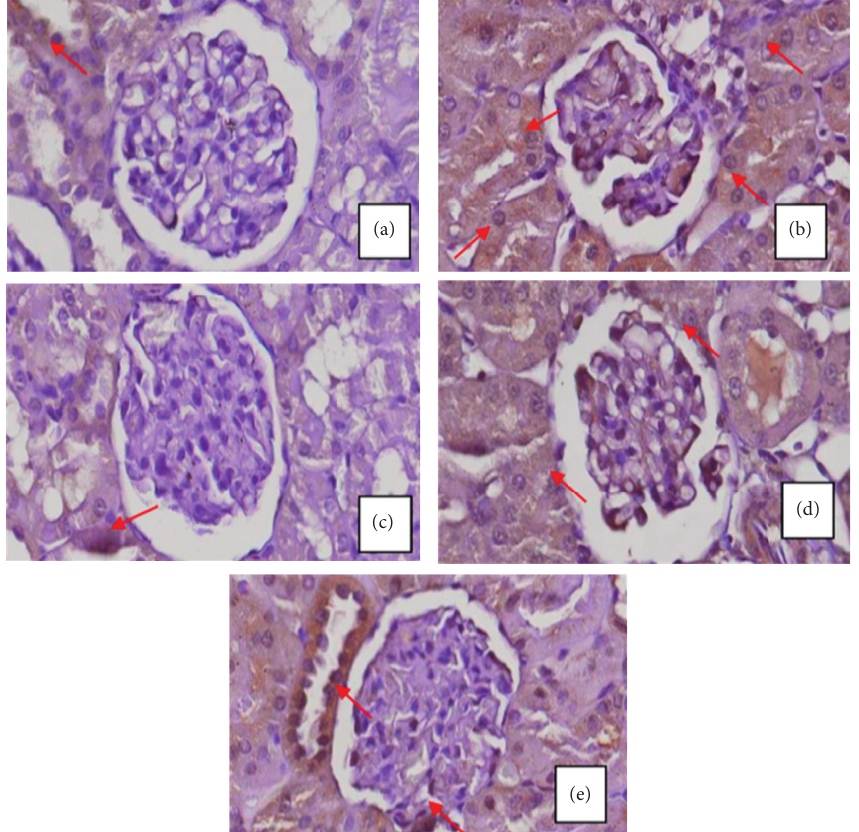
Figure 1: TNF alpha expression in the kidney of (a) healthy rats (group 1), (b) diabetic rats (group 2), (c) diabetic rats that treated with 250mg/kg body weight extracts per day (group 3), (d) diabetic rats that treated with 375mg/kg body weight extracts per day (group 4), and (e) diabetic rats that treated with 500mg/kg body weight extracts per day (group 5). The red arrows show renal tubules with TNF alpha expression. Table 2: TNF alpha expression on the rats’ kidney. Group TNF alpha expression